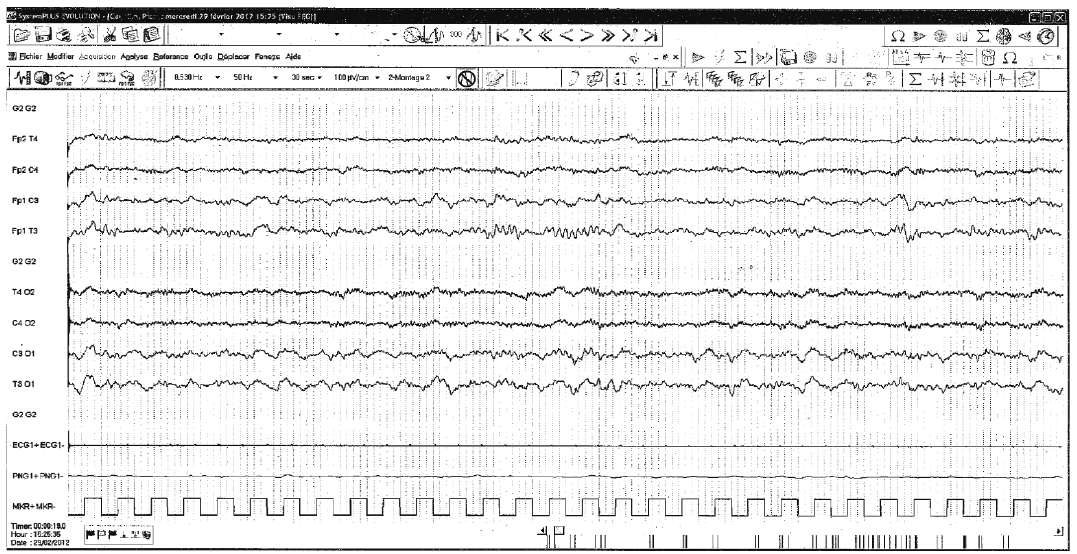
Figure 1: An electroencephalogram showing a nonepileptiform slowing on the left hemisphere in a 19-year-old male HaNDL patient (lines Fp1C3, Fp1T3, C3O1, and